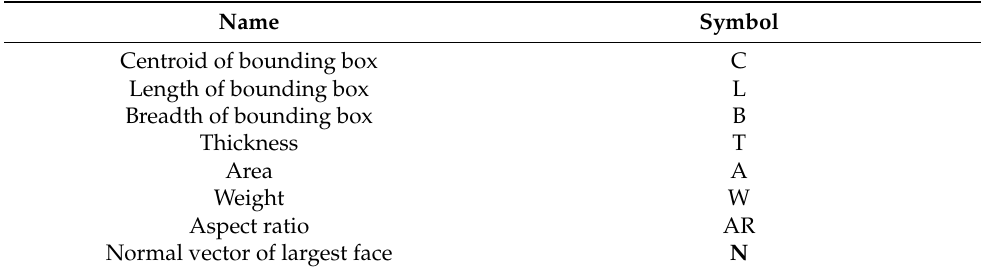
Table 1. Geometric attributes of extracted structural